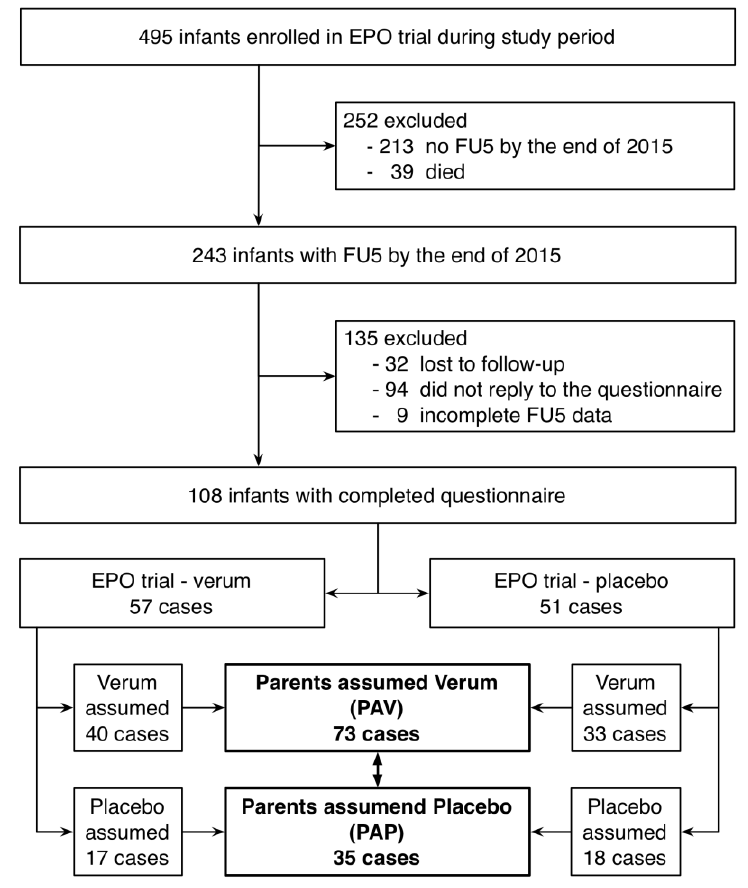
Figure 1. Flow chart of the sample size. FU5 = 5 years of age. Table 2. Perinatal, neonatal, and sociodemographic baseline characteristics of infants included within the study.